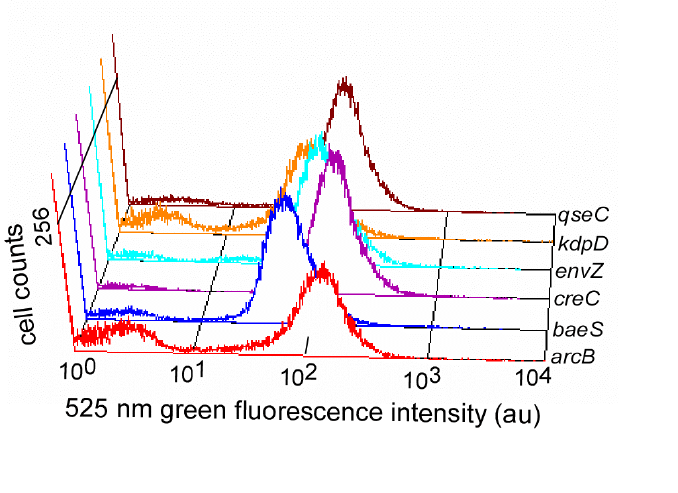
Fig. 3. Single-cell profiling of PhoB activation by noncognate HKs. Single colonies for E . coli strains carrying phoAp - gfp and rhaBp -HK fusions were inoculated into 2-ml 0.1% glycerol MOPS medium with 1 m M L-rhamnose and grown for ten hours in 16-mm tubes, as described in Materials. Green fluorescence was measured by flow cytometry as described in Materials. Results are shown for BW31820 (like BW26910, except rhaBp - arcB ∆ arcA ∆ ( ackA pta ), BW31817 (like BW26910, except rhaBp - baeS ∆ baeR ∆ ( ackA pta )), BW31828 (like BW26910, except rhaBp - creCD ∆ creAB ∆ ( ackA pta )), BW31827 (like BW26910, except rhaBp - envZ ∆ ompR ∆ ( ackA pta )), BW31824 (like BW26910, except rhaBp - kdpD ∆ kdpE ∆ ( ackA pta )), and BW31819 (like BW26910, except rhaBp - qseC ∆ qseB ∆ ( ackA pta